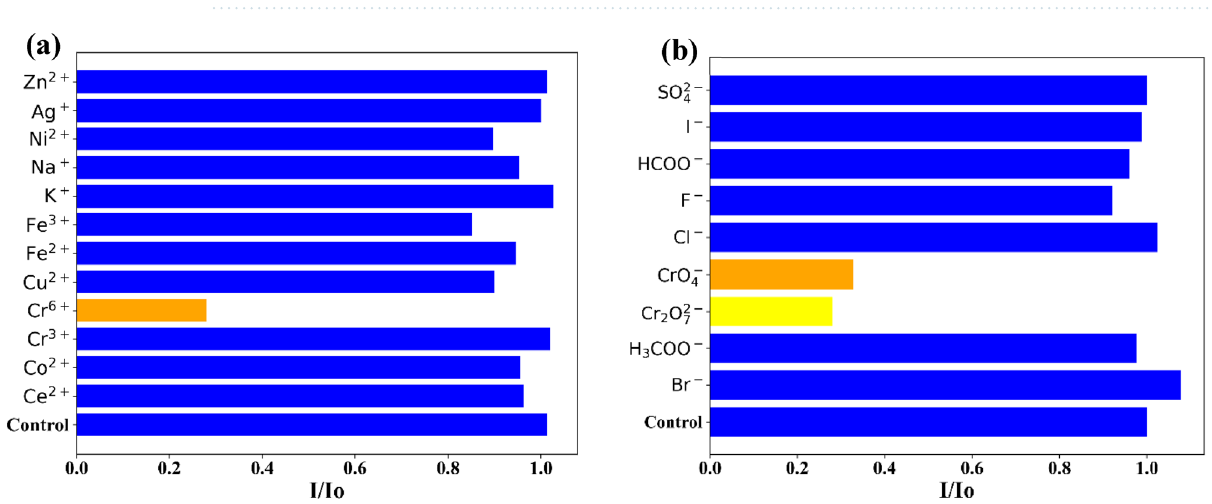
Figure 7. pH effect on the emission intensity of N-CQDs. Representative samples selected to show the highest and lowest [N] doping levels: ( a,b ) N-0.25, ( c,d ) N-10.